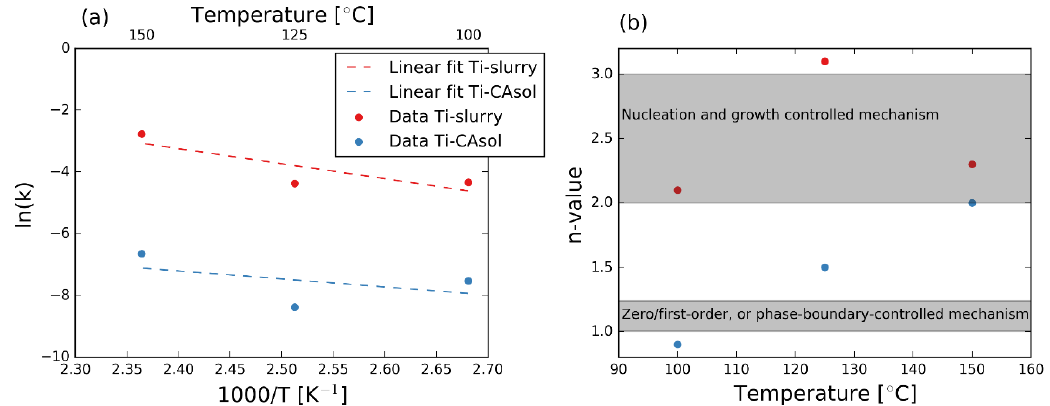
Figure 5. ( a ) Arrhenius plots for the Ti-slurry and Ti-CAsol with linear regression fits; ( b ) n -values plotted against temperature. Grey areas show physically meaningful values for n